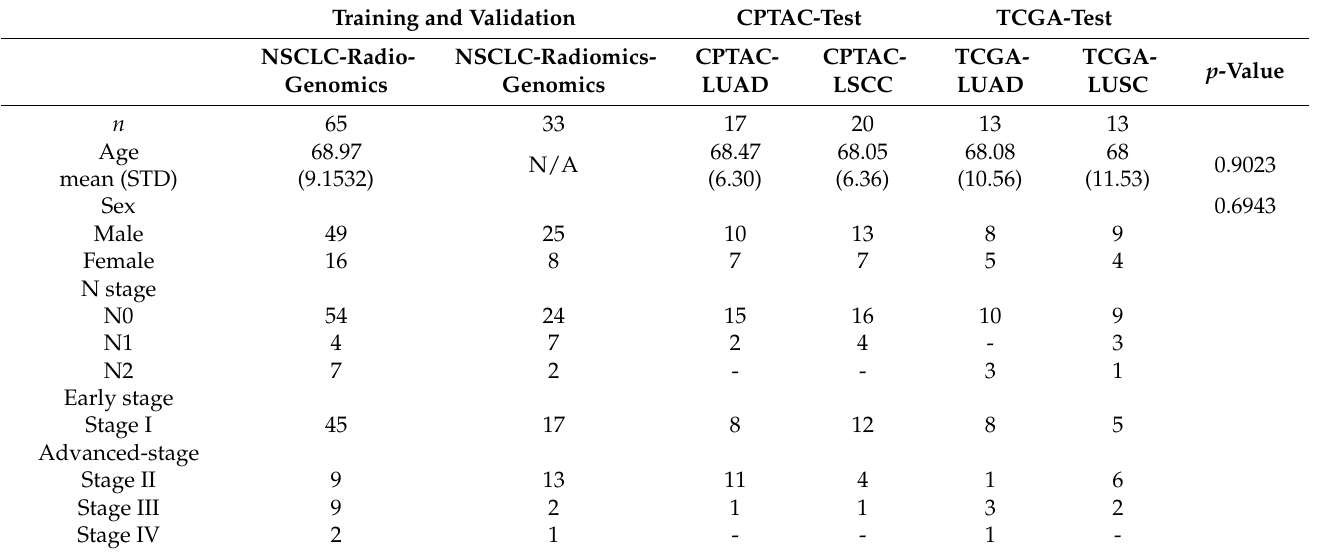
Table 1. Patient information for various